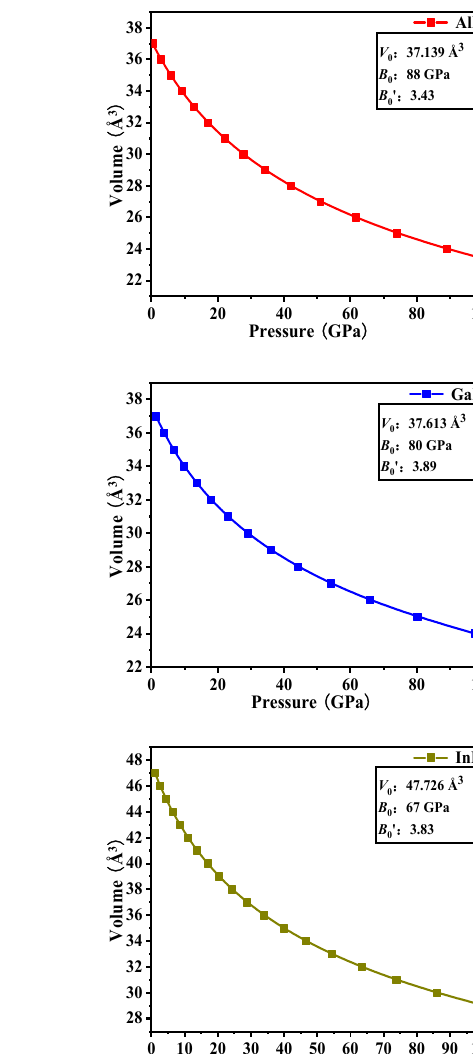
Figure 2. The 3D crystal structure of P 6 4 22- X P ( X = Al, Ga, or In).